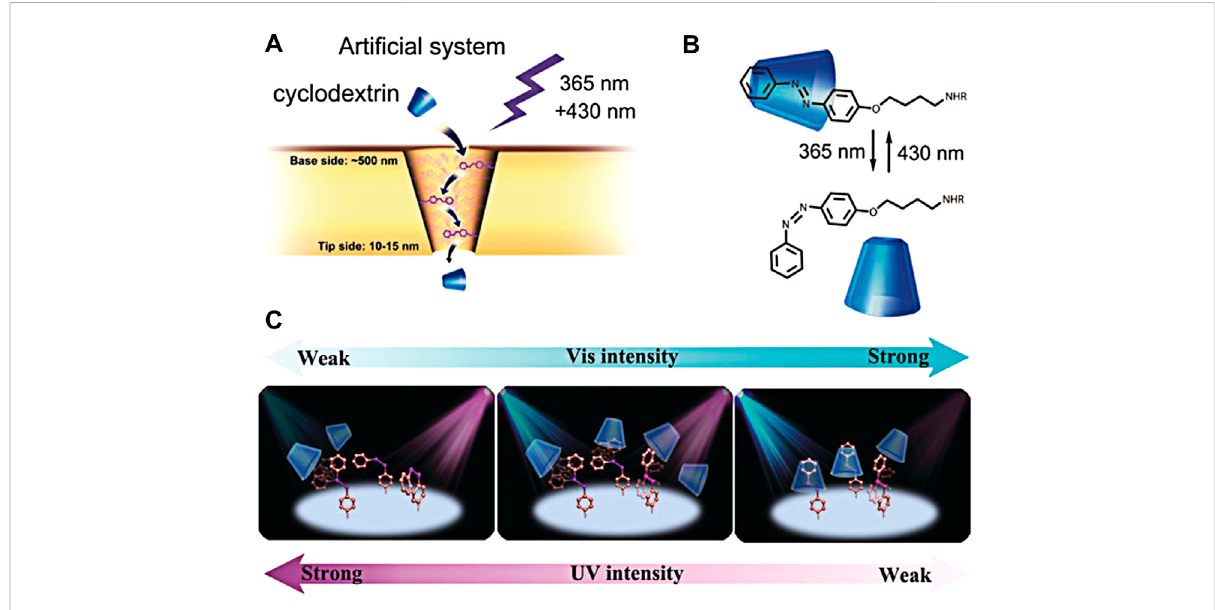
FIGURE 4 (A) Cyclodextrin transporter of arti fi cial nanochannel systems; (B) schematic diagram of inclusion and de-inclusion of cyclodextrin – azobenzene inUV/visiblelightresponse; (C) selective transportbehaviorofazo groupson theinnersurfaceofnanochannelunderthe different irradiation of visible light (blue) and ultraviolet light (purple). A single high intensity of visible or ultraviolet light will reduce the transmission rate of β -CD. Only the matching intensity of visible and ultraviolet light can promote the transmission of β -CD (Xie et al., 2018b) Copyright @ 2018 (Wiley).